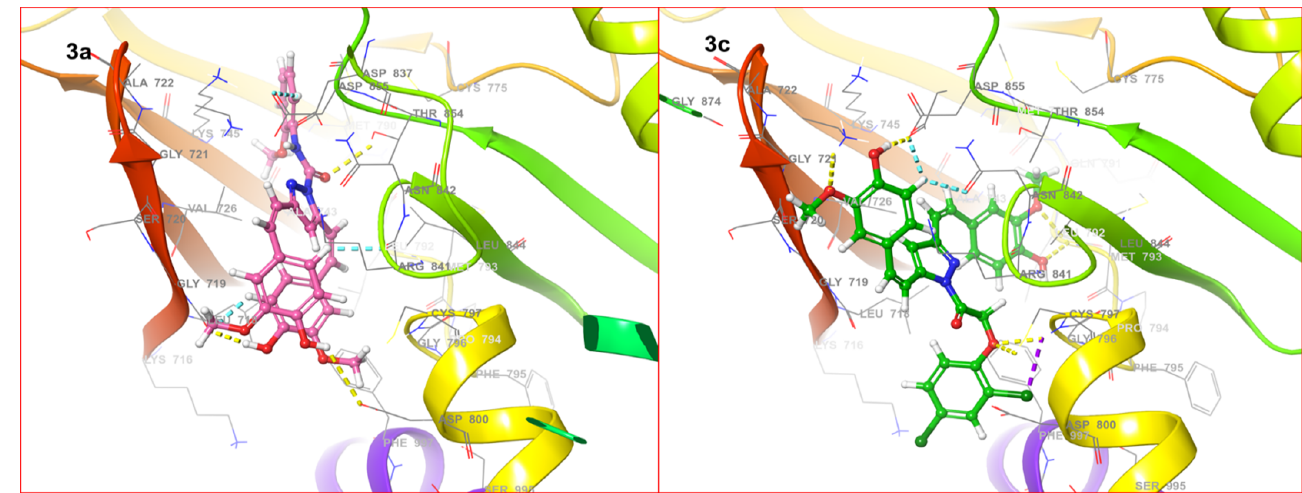
Figure 4. The 3D interactions of ligands 3a,c against the active site of EGFR.